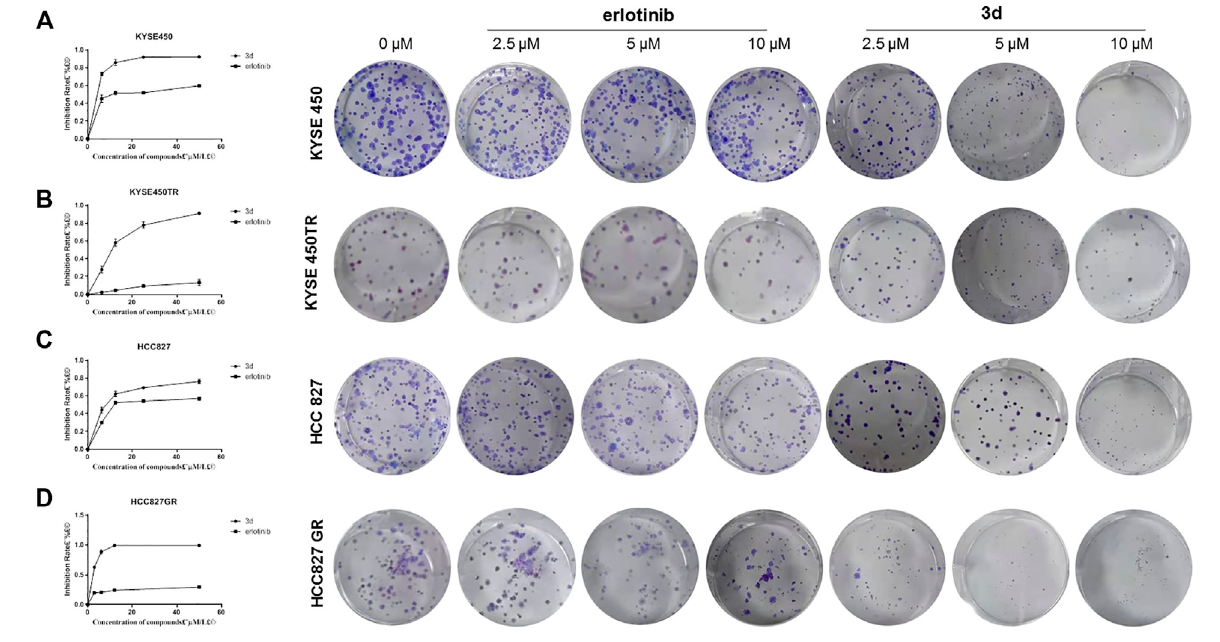
FIGURE 3 | Plate clone results of 3d and erlotinib. (A) and (B) The proliferation inhibitionof 3d and erlotinib on KYSE450 and KYSE450TRcells. (C) and (D) The proliferationinhibitionof 3d anderlotinibonHCC827andHCC827GRcells.UnpairedStudent ’ sttestwasusedinPlateclone.* p < 0.05,** p < 0.01,*** p < 0.001.Errorbars represent the mean ± SD.